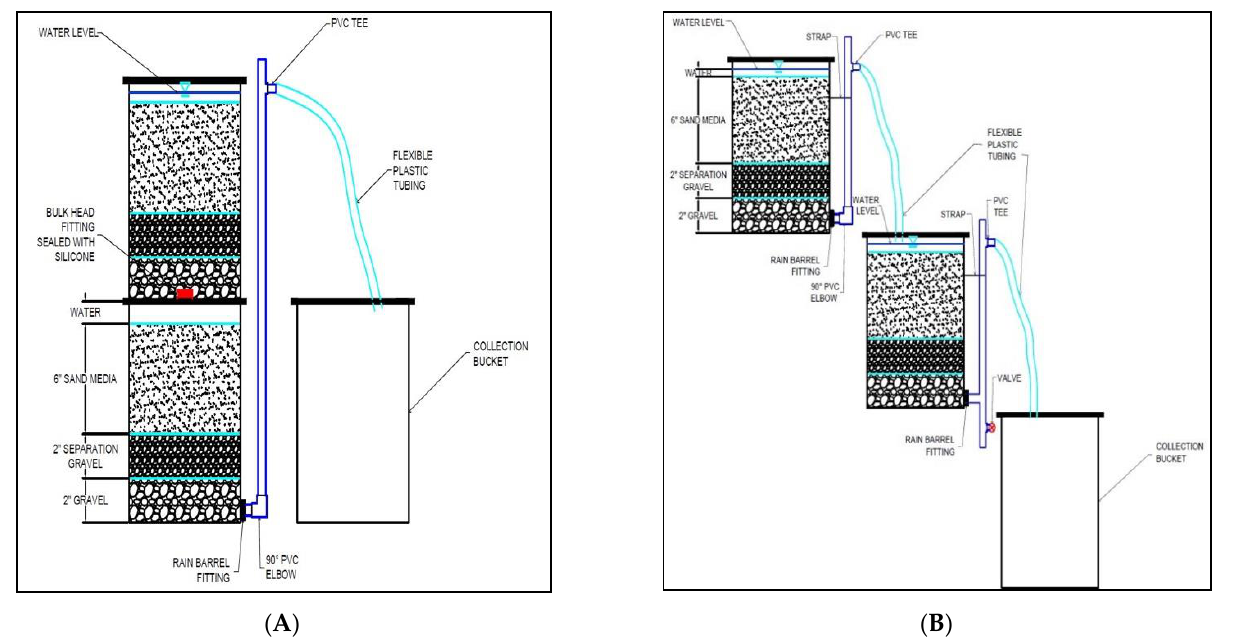
Figure 4. ( A ) Schematic diagram of the two-stage BSF design developed by the HS students. ( B ) Schematic diagram of the two-stage BSF design developed by the Rice and Yang.